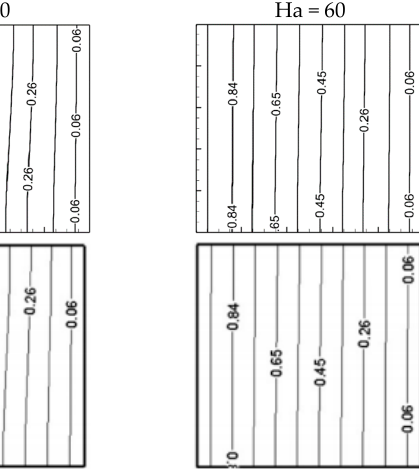
Figure 2. Comparison of y-velocity ( left ) and temperature ( right ) along the mid-span of a two–dimensional cavity between the present work and (Ghasemi et al., 2018 for various values of Hart- mann and Rayleigh numbers at ( φ = 0.03).